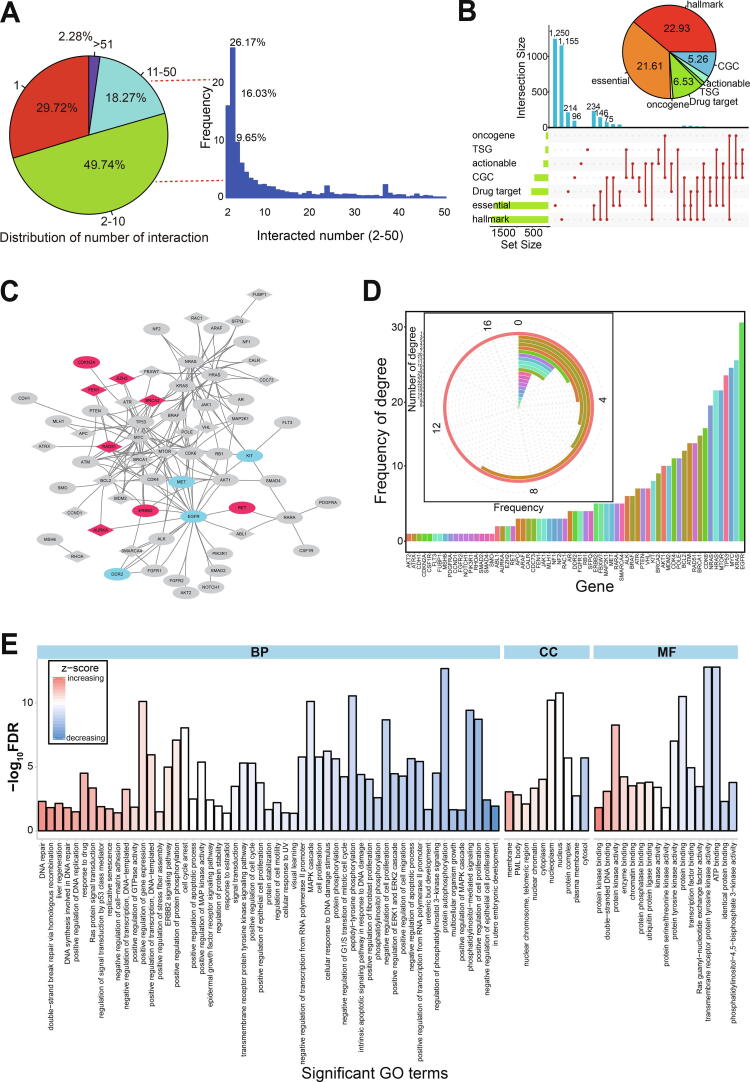
In-depth analysis of involved genes in synthetic lethal interaction. A. Number distribution of interacted genes. The left pie distribution shows the total distributions of interacted gene numbers, and the right histogram shows the detailed distributions of interacted numbers (2–50). B. Distribution of gene classifications for involved all genes, and a pie distribution shows the detailed percentages of each gene type. C. The network of gene interactions. All of these involved genes have potential important roles in tumorigenesis, and they are validated with at least four gene characteristics in Fig. 2B. The red circle shows up-regulated expression patterns in BRCA (BRCA as an example), the blue circle shows down-regulated expression, and the grey circle shows normally expressed. D. Distribution of interacted numbers based on each gene, and the frequency of interaction numbers is also presented. E. Significant enriched GO terms based on the screened 65 genes. BP, biological process; CC, cell component; MF, molecular function. (For interpretation of the references to colour in this figure legend, the reader is referred to the web version of this article.)